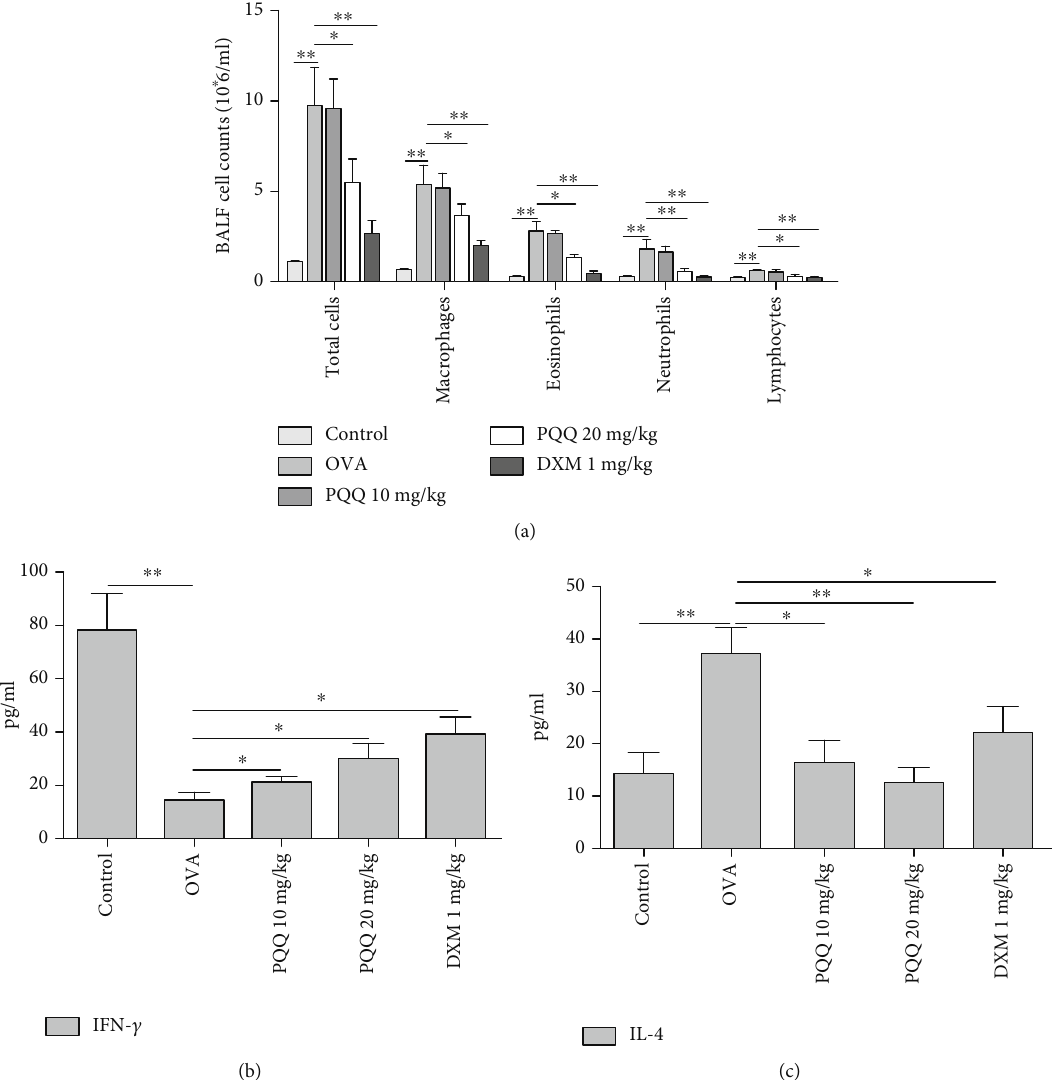
Figure 4: PQQ administration reduces BALF in fl ammatory cell counts and changes IFN- γ and IL-4 secretion. (a) Total cell numbers in BALF were counted with an Automatic Blood Cell Analyzer and speci fi c di ff erential cell counts in BALF were tested by fl ow cytometer. (b) Levels of released IFN- γ in BALF as measured by ELISA. (c) Levels of released IL-4 in BALF measured by ELISA. The columns and error bars represent the means and SEMs ( n = 5 per group). ∗ P < 0 : 05 , ∗∗ P < 0 : 01 . Similar results were obtained in at least three independent